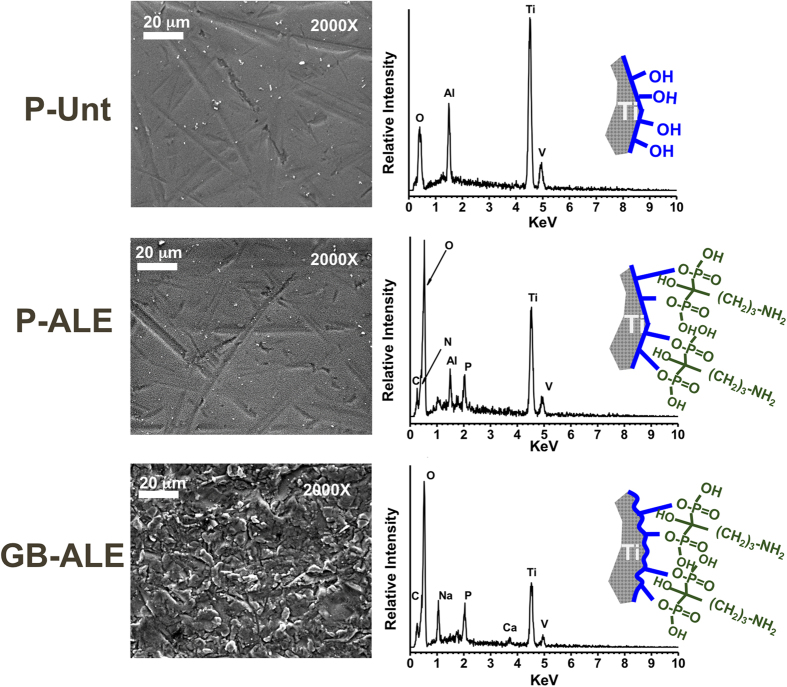
SEM and EDX analysis spectra for P-Etch, P-ALE and GB-ALE surfaces.